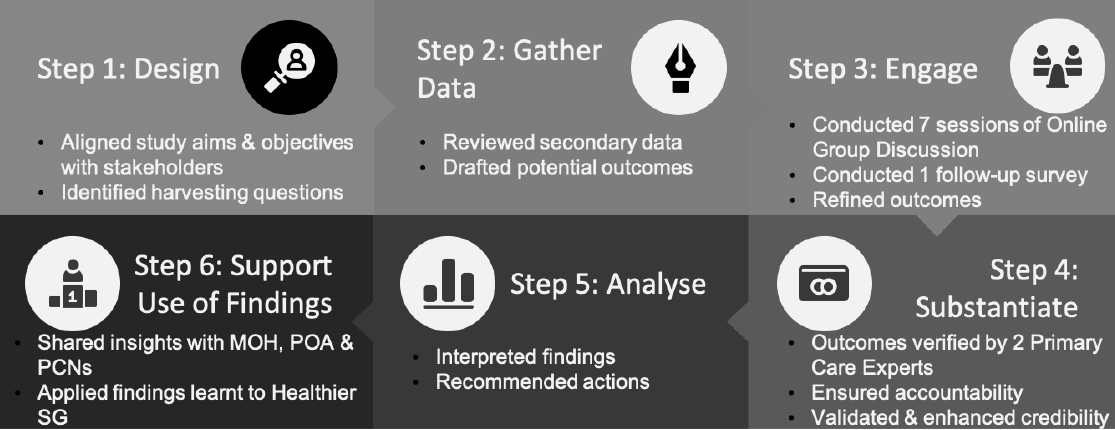
Figure 2. Diagrammatic representation of outcome harvesting six step process.